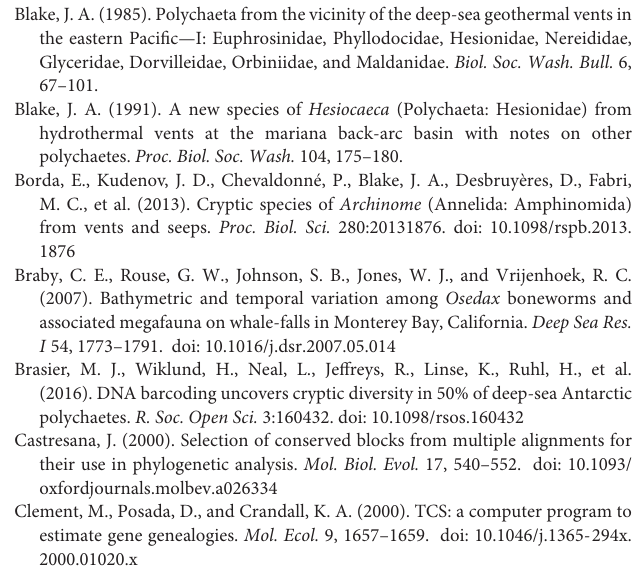
Figure S1 | Phylogenetic relationship of Sirsoe based on maximum likelihood (ML) analysis of: (A) COI and (B) 16S datasets. Values before slash are bootstrap supports of ML (only > 50%) and after are posterior probabilities of Bayesian inference. Asterisks indicate 100% of support for ML and BI; ‘-‘ indicates node absent on BI. TABLE S1 | Locality, depth and GenBank accession number of sequences employed in this study. TABLE S2 | Average of uncorrected genetic distance (p-distance) among Sirsoe species. Values above the diagonal are interspecific 16S distance and below are COI distance. Diagonal values (in bold) are intraspecific distances; top is 16S and inferior is COI. Dark red and green represent high values and light colors low values. TABLE S3 | List of valid Sirsoe species up to date, including type locality, other occurrences, depth range (in meters) and type of chemosynthetic-based ecosystem used by each